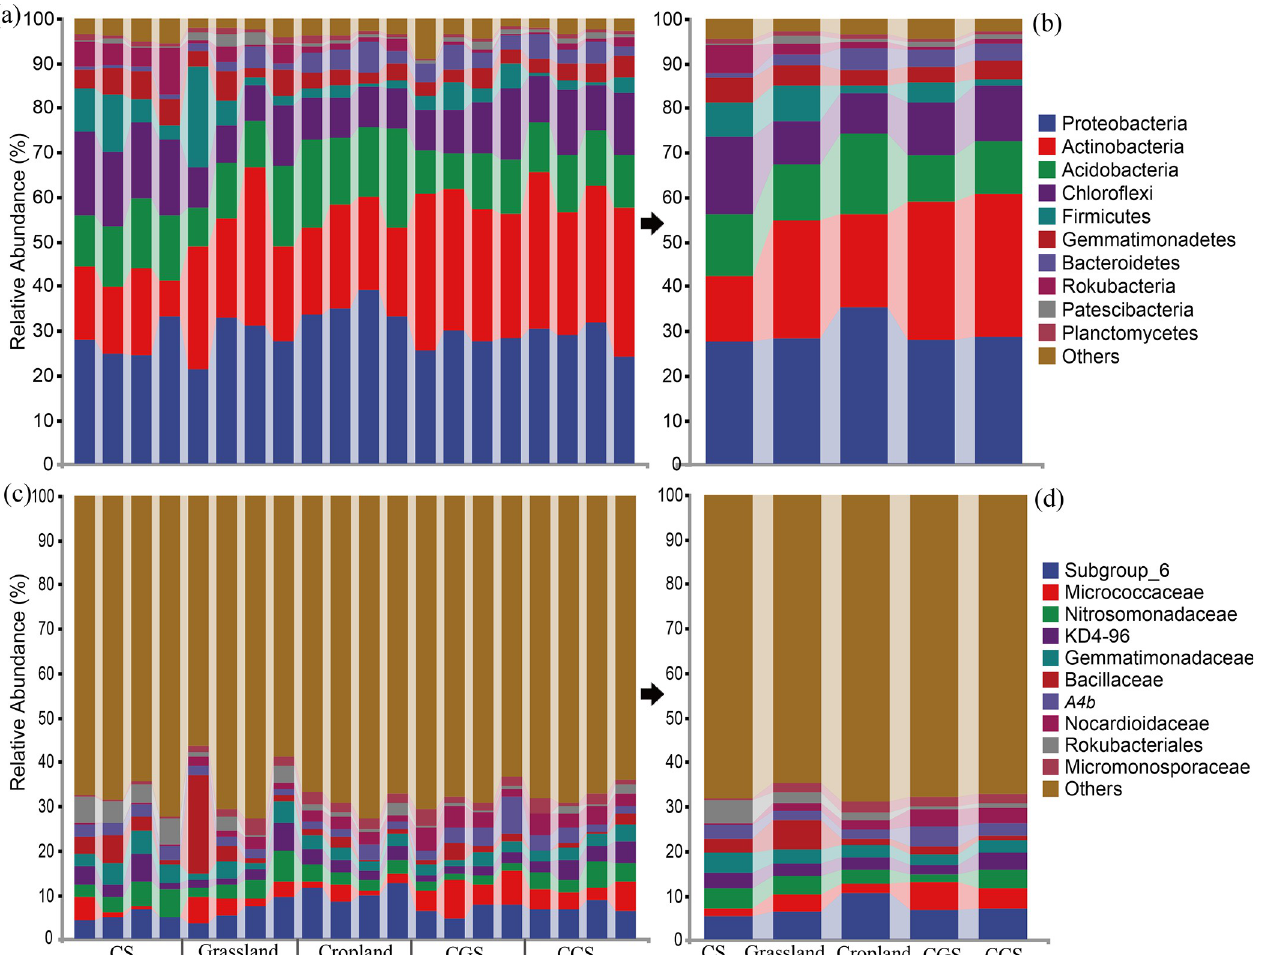
Fig 3. Taxonomic composition analysis in levels of phyla and families in the five soil types. Bacterial composition in phyla level of all the samples (a), phylum level of the five soil types (b), family level of all the samples (c), family level of the five soil types (d).